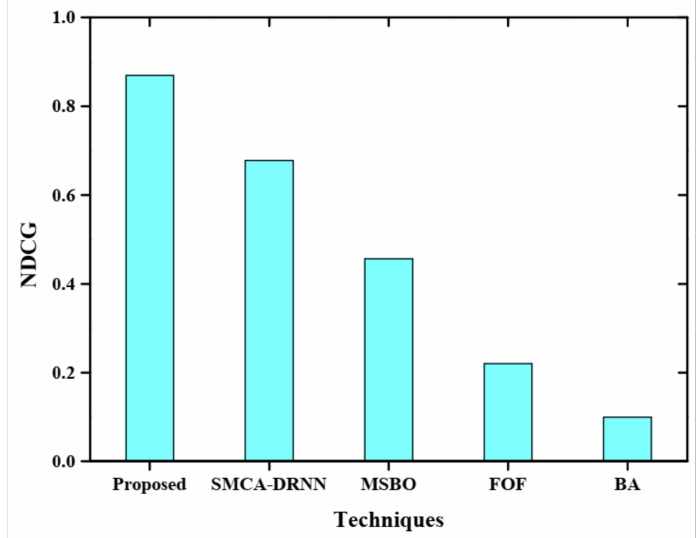
Figure 12. Comparative analysis of NDCG with query